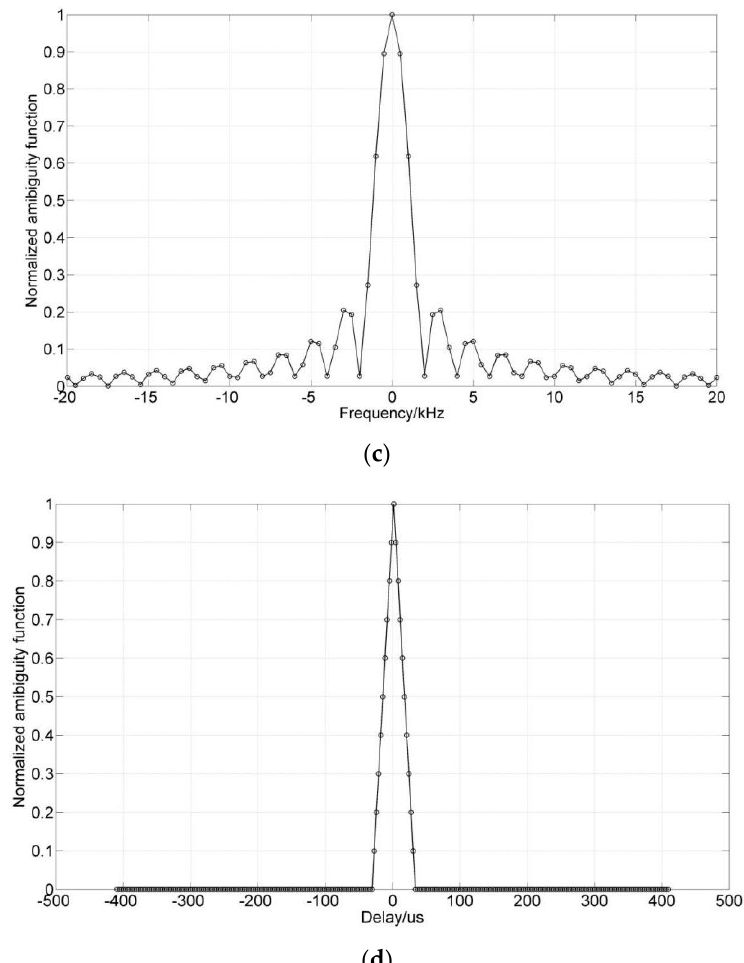
Figure 1. Normalized Ambiguity Function Analysis of Complete Complementary Code: ( a ) Normalized ambiguity function; ( b ) Contour map corresponding to ( a ); ( c ) Normalized ambiguity cut for Frequency = 0 kHz; ( d ) Normalized ambiguity cut for Delay = 0 μ s.